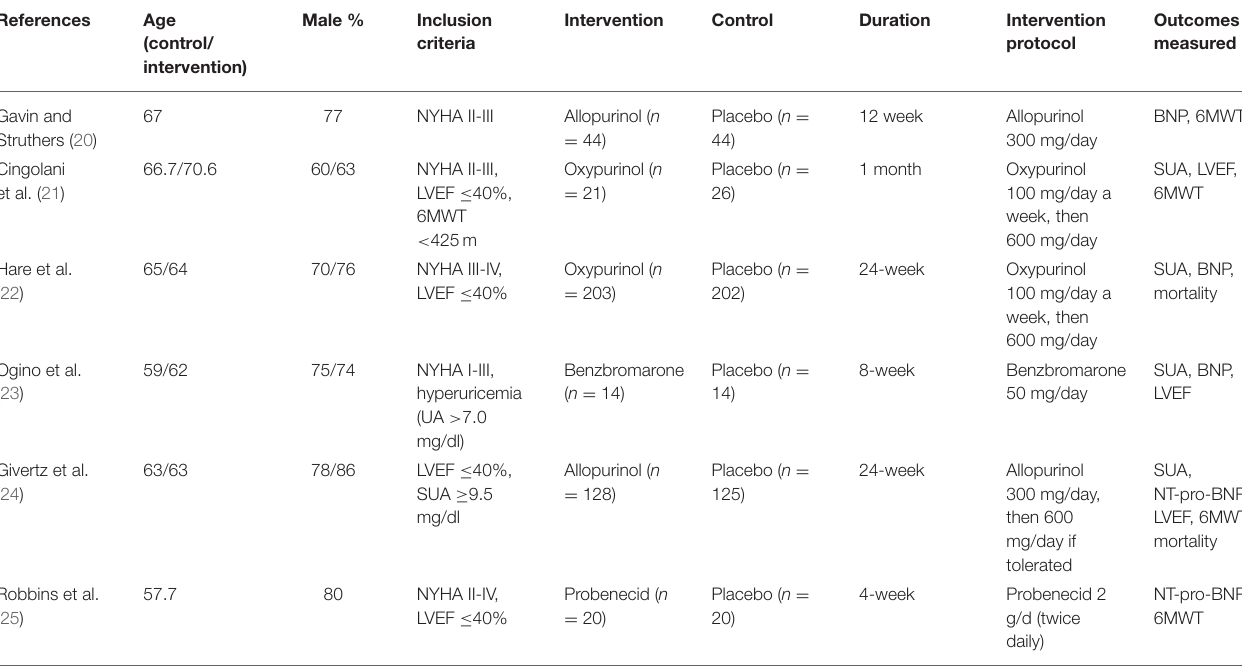
TABLE 1 | Characteristics of included